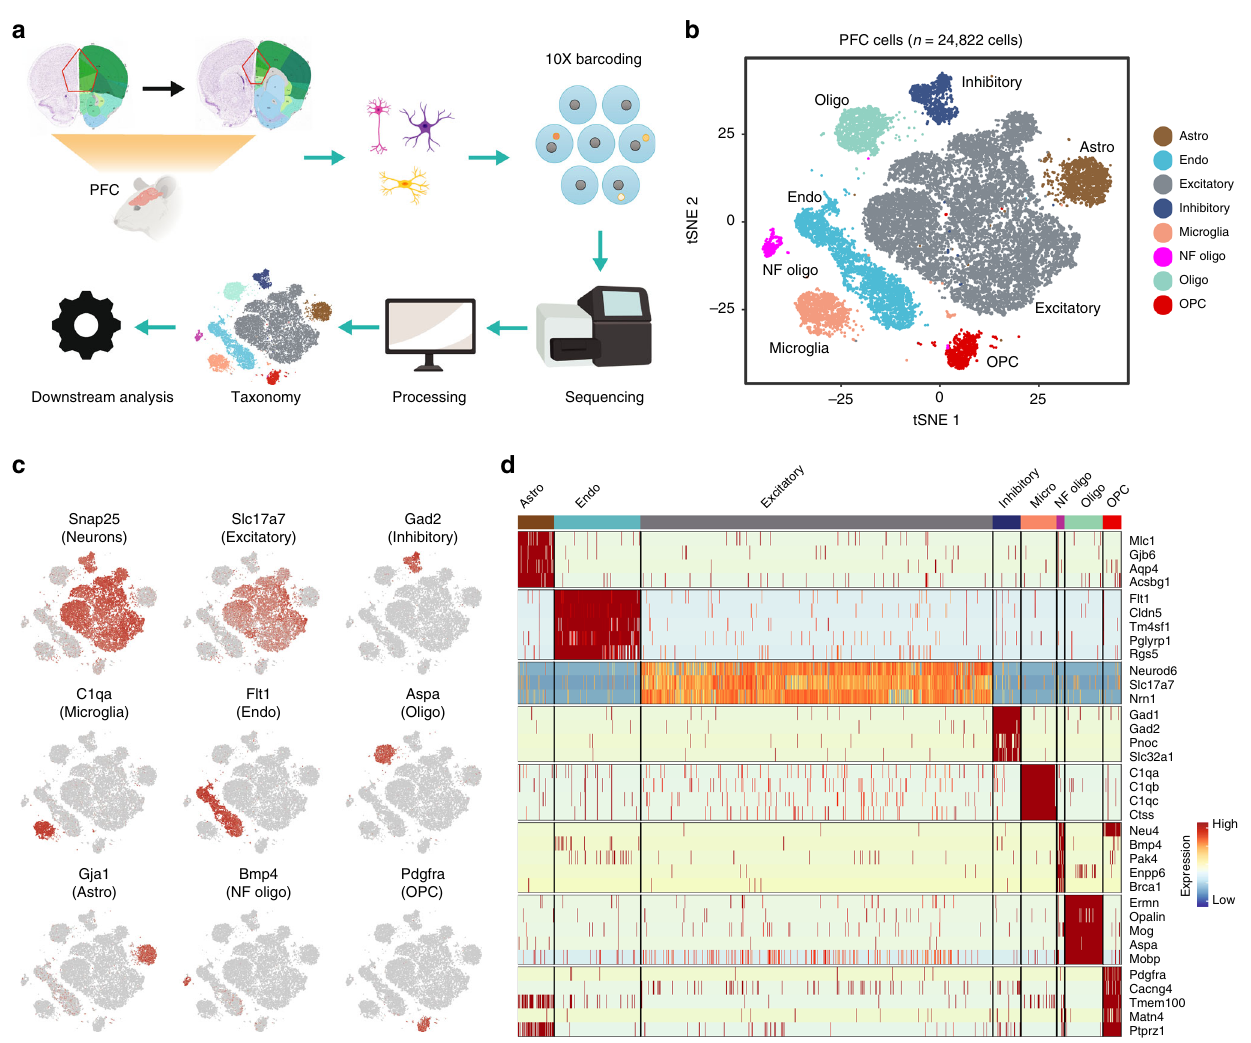
Fig. 1 Transcriptome-based cell classi fi cation in mouse PFC. a Schematic of the experimental design. PFC sections (red outline) were isolated for scRNA- Seq. Created with BioRender.com. b t-SNE plot showing the broad clustering of PFC cell types based on transcriptome. c Expression of cell type-speci fi c markers in each broad cell cluster color-highlighted on t-SNE plots. d Single cell heat map showing cell type-speci fi c gene marker expression in the different PFC cell